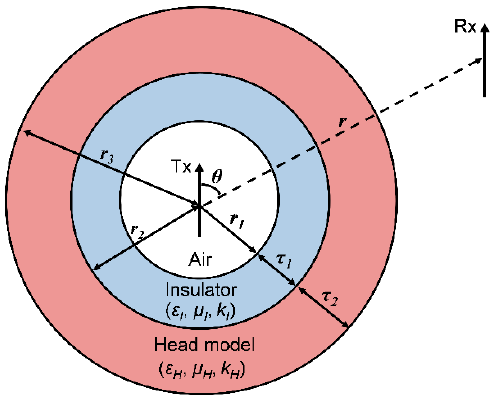
Figure 1. Multi-layered spherical shell (MSS) model for a brain-implanted antenna (Tx) with a receiver antenna (Rx) outside the model.